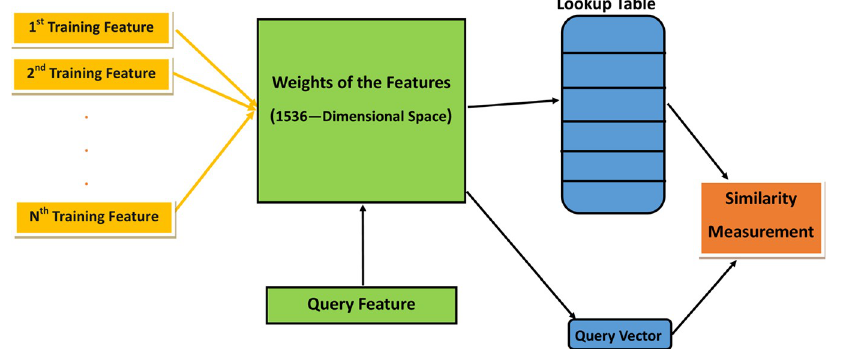
Fig 5. Training features and query feature process before the similarity